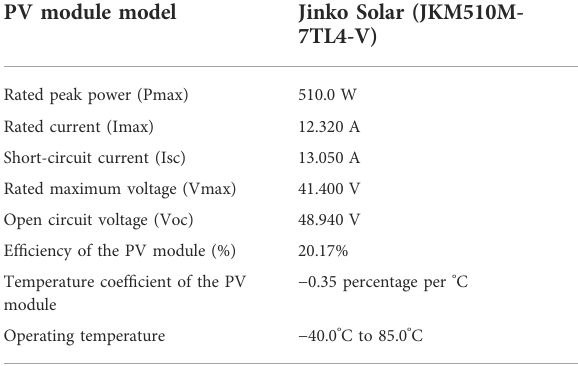
TABLE 3 Solar photovoltaic module speci fi cation.